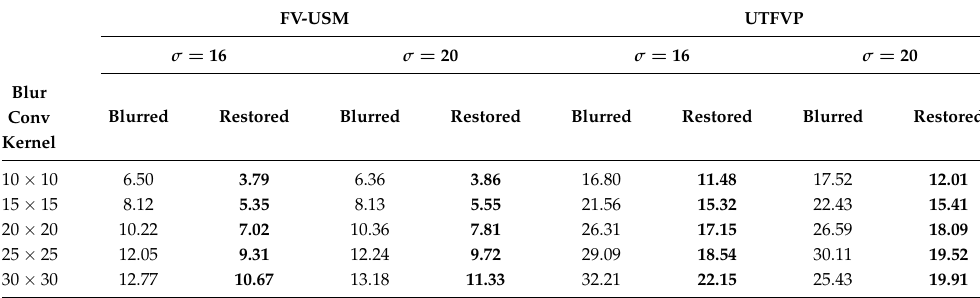
Table 6. EERs (%) of FV-USM and UTFVP with different σ and blur Conv